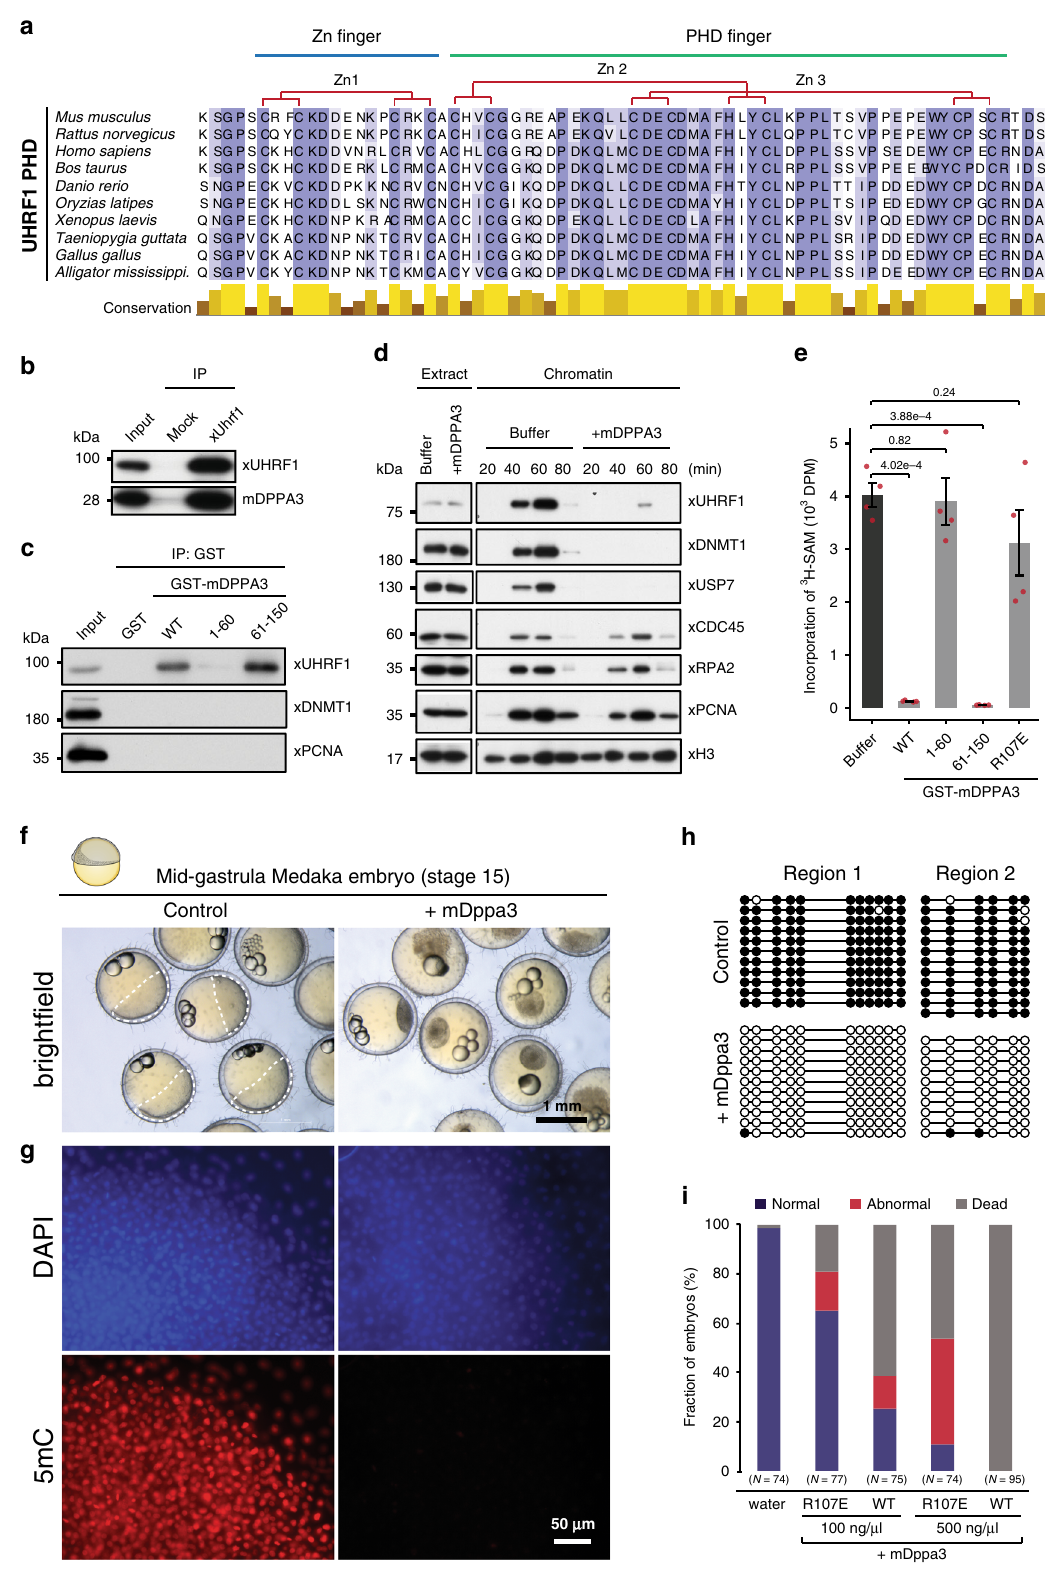
xDNMT1 binding, did not signi fi cantly alter maintenance DNA methylation activity (Fig. 7e and Supplementary Fig. 8d, e). Taken together, our data demonstrate DPPA3 to be capable of potently inhibiting maintenance DNA methylation in a non-mammalian